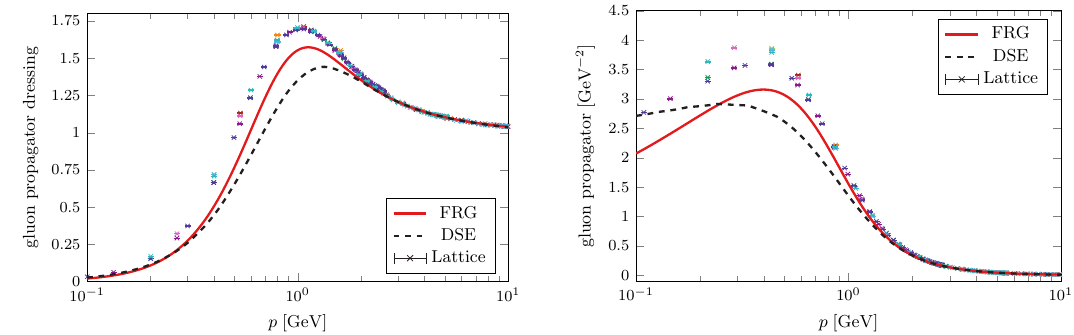
( p ) (left) and the dimensionful propagator A